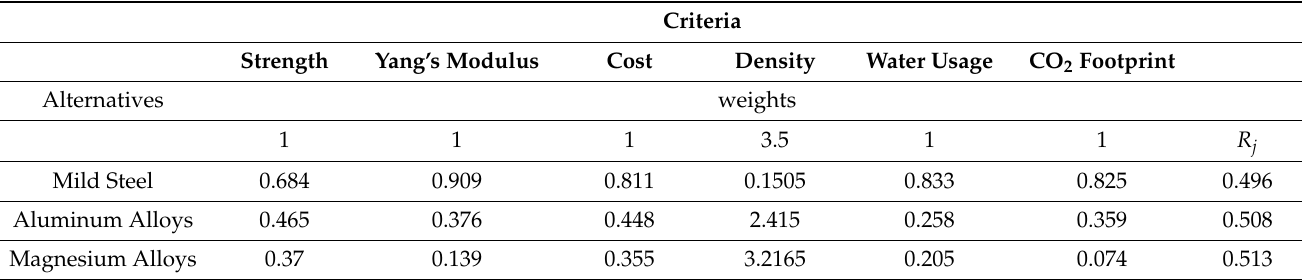
Table 6. Ranking decision score if the density is given about 3.5 times importance than the others.